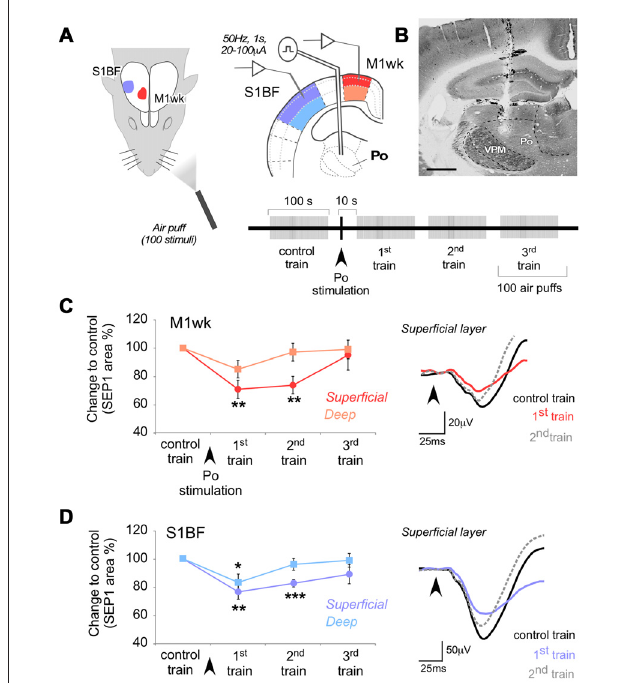
FIGURE 2 | Po stimulation modulates subsequent responses in M1wk and S1BF to passive multi-whisker stimulation. (A) Diagram of the experimental protocol. Tactile stimulation (air puffs) was applied to the contralateral whiskers (four trains of 100 stimuli, 1 Hz). A single train of electrical pulses (50 Hz, 1 s, 20–100 µ A) was applied to Po immediately after the first train of air puffs (“control train”). SEPs were recorded in the S1BF and M1wk cortices. In each area, separate recordings were made in the superficial and deep layers (shaded in different color hues, respectively). (B) Representative image of a coronal brain section counterstained with cytochrome oxidase showing the location of the bipolar electrode tip in Po. Bar = 500 µ m. (C) Effect of Po electrical stimulation on tactile responses in M1wk cortex. Left: changes in SEP1 area are shown as the percentage of differences to control values. Right: representative individual SEPs recorded during control (black line), first (colored line) and second (gray dashed line) train. Arrowheads indicate whisker stimuli application. (D) Effect of Po stimulation on tactile responses in S1BF cortex. Conventions as in (C)